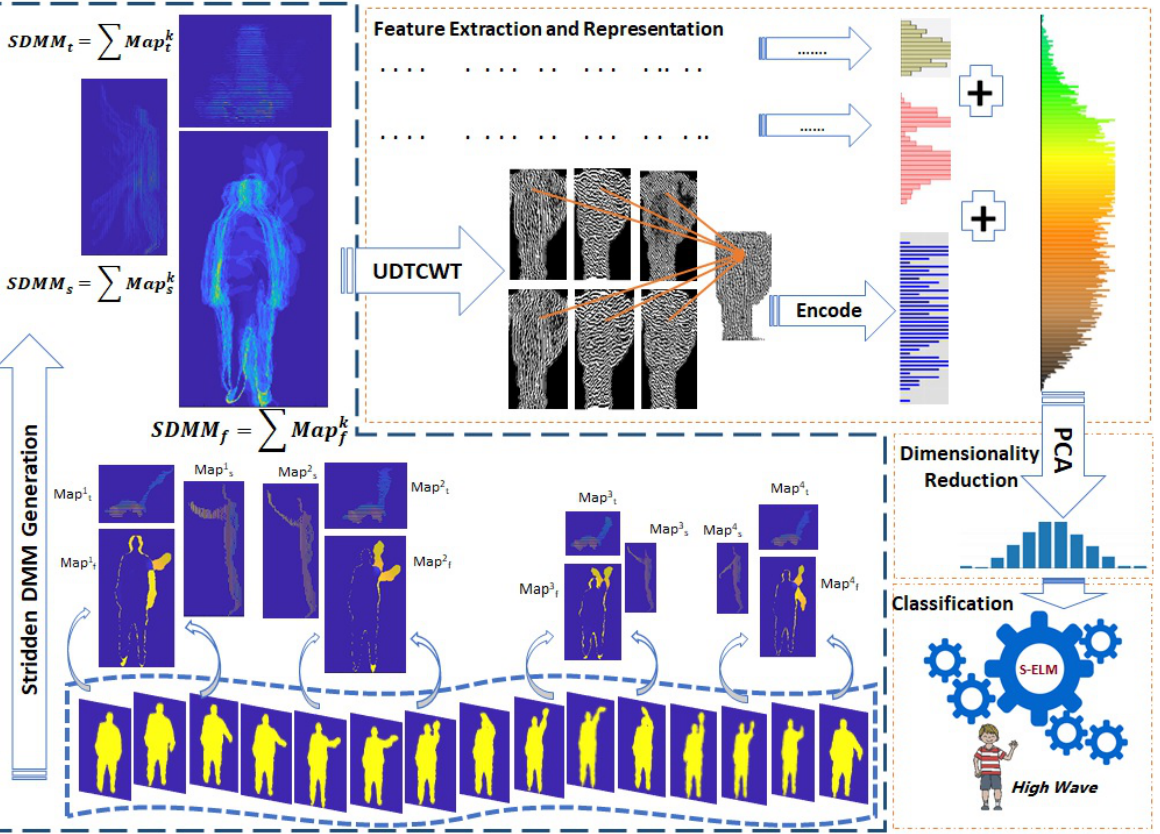
Figure 1. Proposed methodology for Stridden Depth Motion Map generation, extracting UDTCWT features and Action Recognition from Depth